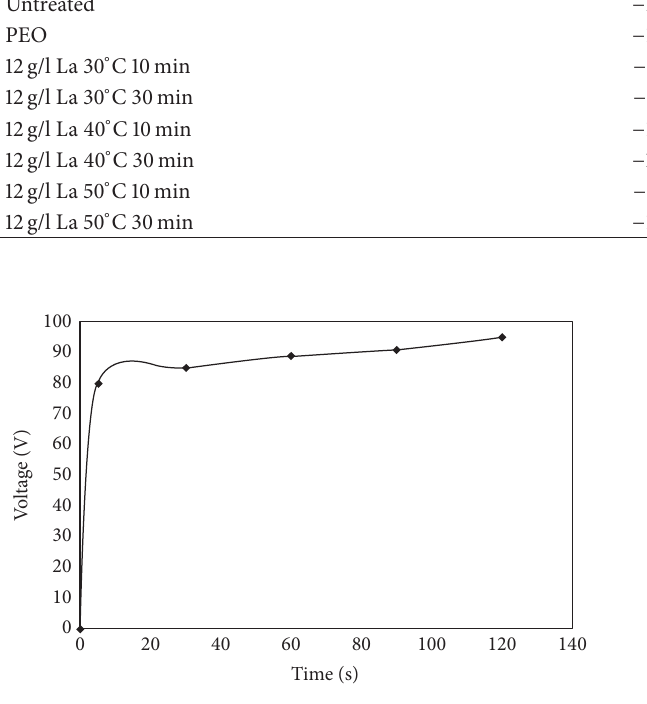
Figure 1: Voltage versus time plot for PEO process.